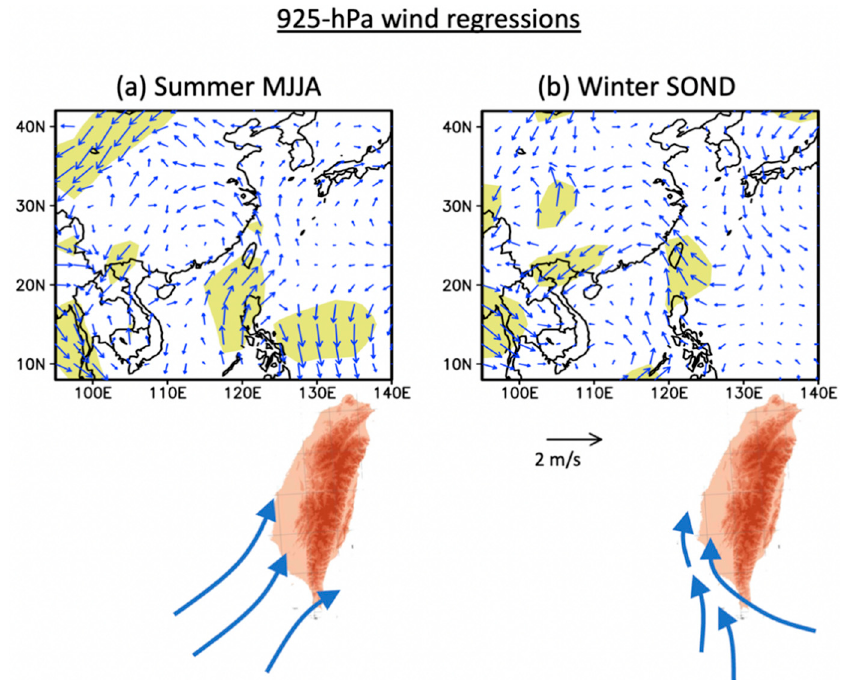
Figure 5. Same-year 925-hPa wind anomalies (vectors) regressed with the Pest Index for the ( a ) summer and ( b ) winter seasons, while the shading indicates significant regression coefficients of the wind speed. Schematic illustrations of the wind pattern near Southern Taiwan are shown in the bottom maps.